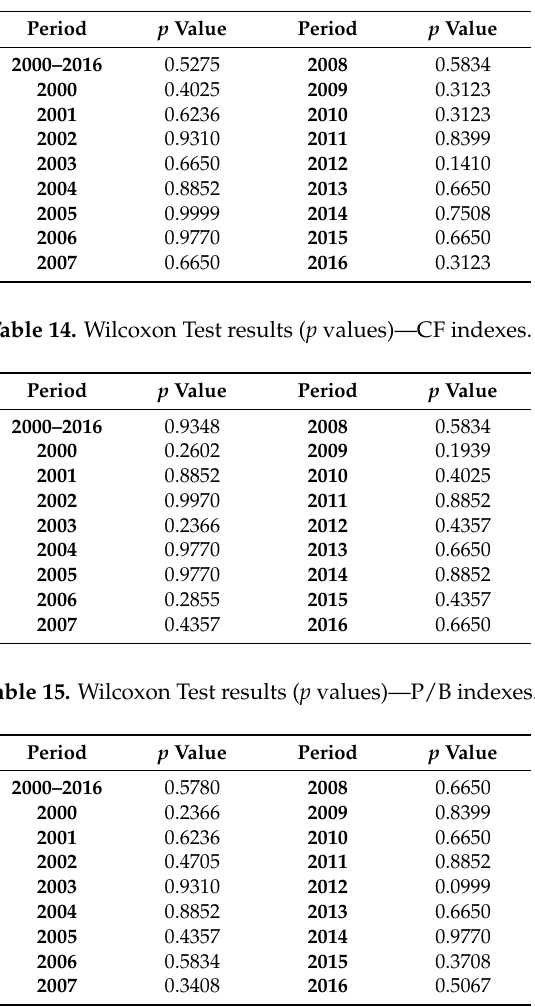
Table 13. Wilcoxon Test results ( p values)—P/E indexes.